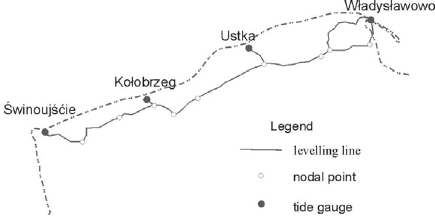
Fig 5. Selected tide gauge stations at Polish coastline During the first stage the tide gauge data (year mean values) were subjected to smoothing using the moving average method.